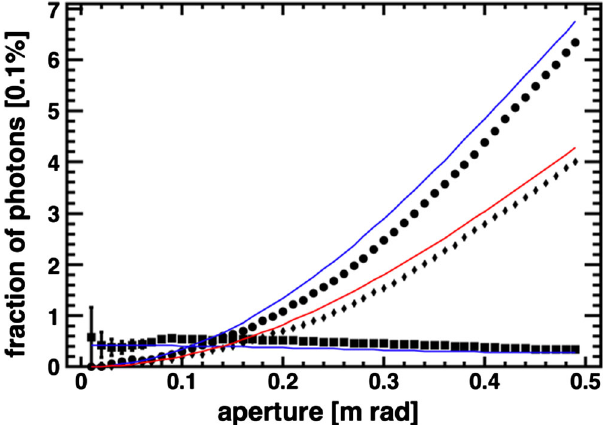
FIG. 4. The fraction of photons for the second (quadratic curves) and third (nearly linear curves) harmonics for purely circularly (red line and black diamonds) and linearly (blue lines and black dots and squared) polarized laser beams using the analytical formula (blue and red solid lines), and CAIN simu- lations (black markers).